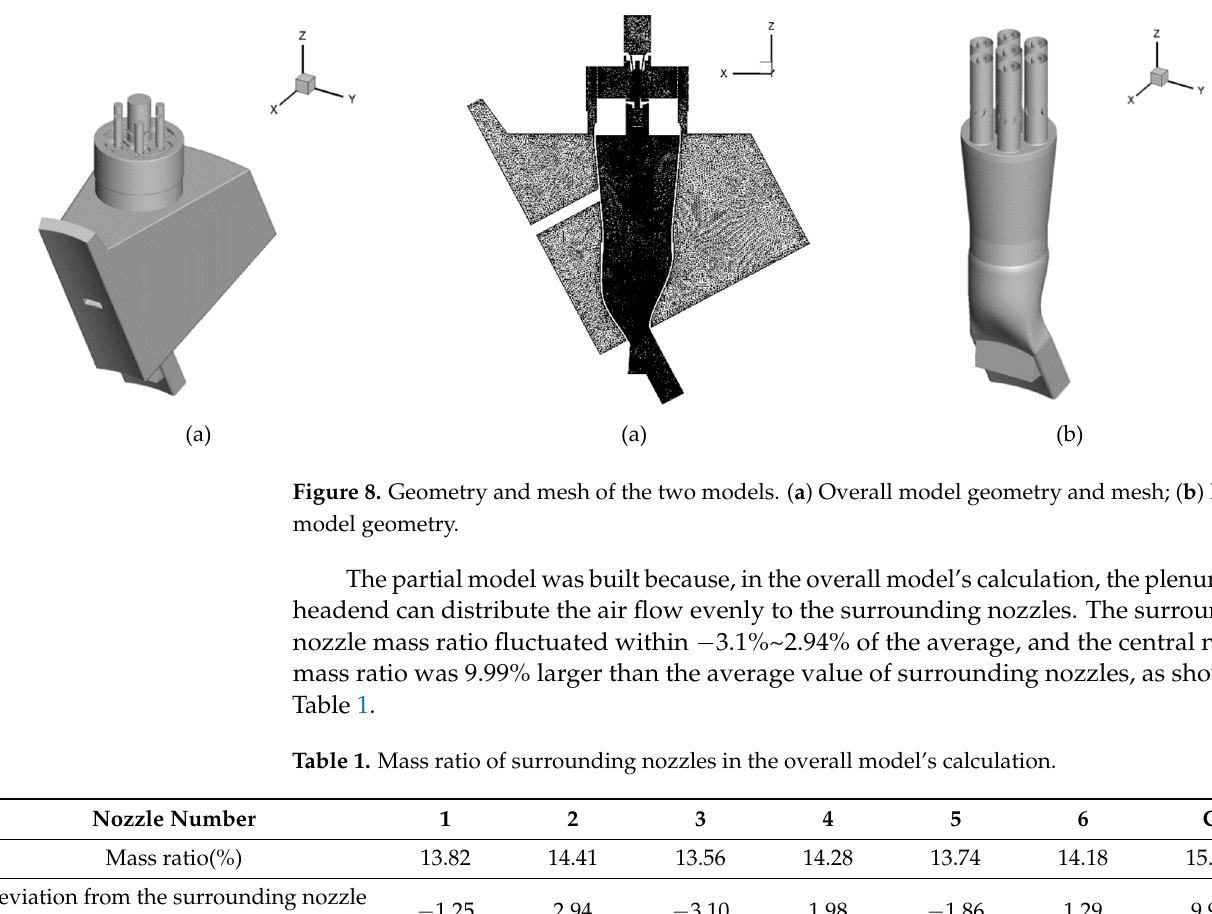
Table 1. Mass ratio of surrounding nozzles in the overall model’s calculation.